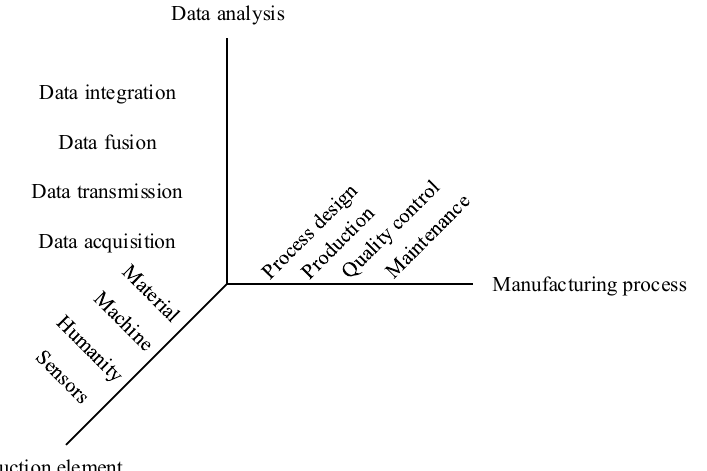
Figure 1. Data sources and applications in production processes.